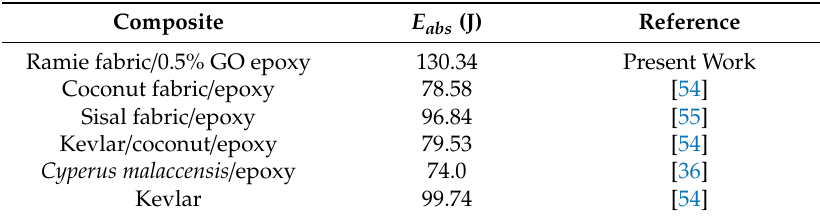
Table 2. Energy absorption in ballistic tests of different composite materials.